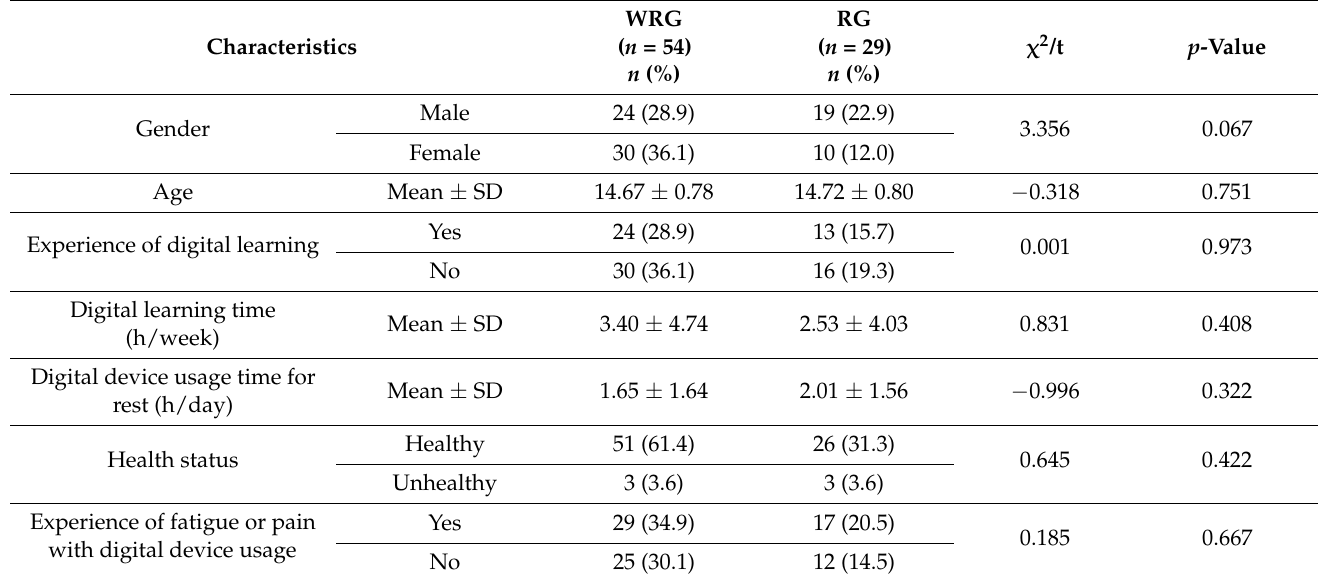
Table 1. Participants’ general characteristics and homogeneity between without-risk and risk groups ( N = 83).